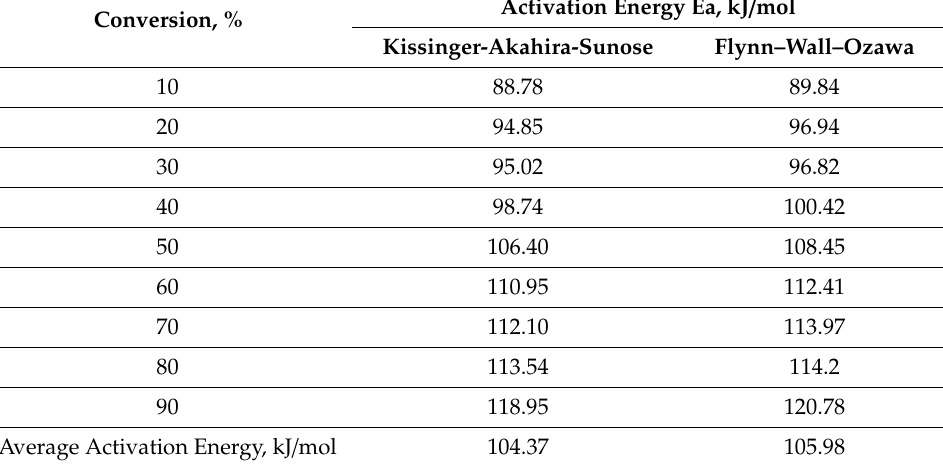
Table 1. The activation energies calculated using the isoconversional methods Kissinger–Akahira–Sunose and